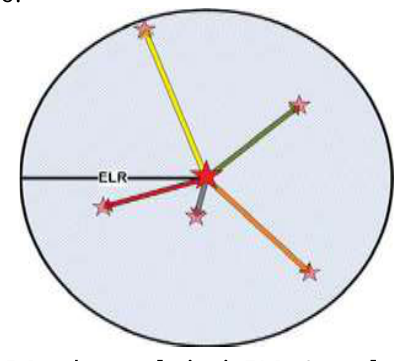
Figure 4. Optimal layout when n is even.